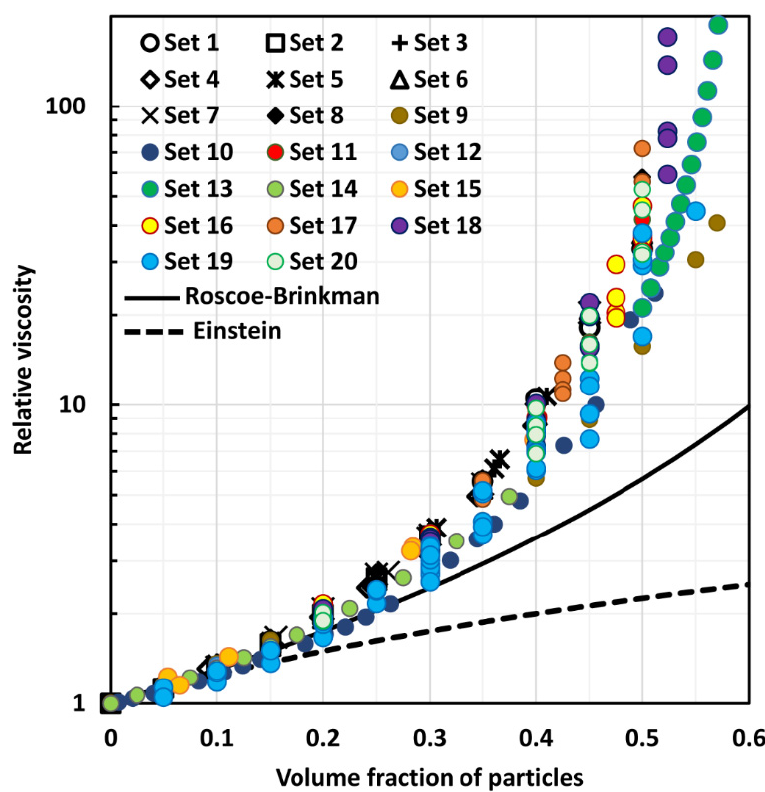
Figure 6. Comparison of experimental viscosity data for suspensions of non-Brownian hard spheres with the predictions of Einstein equation and Roscoe-Brinkman model.